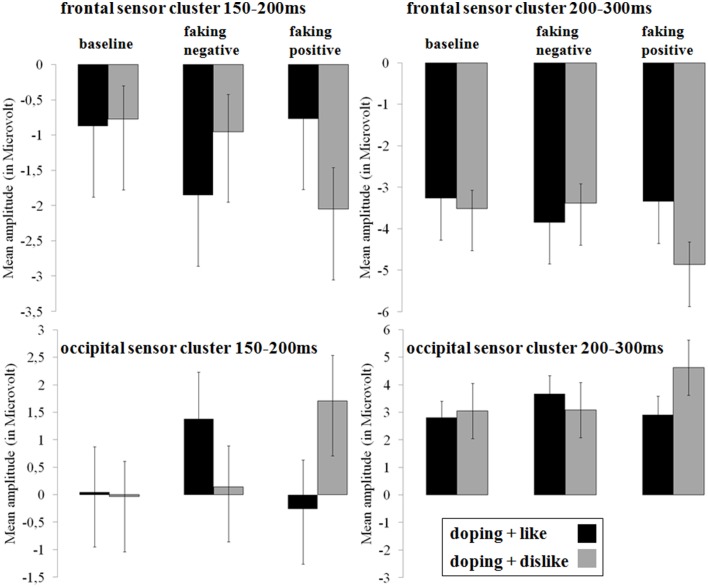
Mean amplitudes in microvolt for early effects over frontal and occipital sensor clusters. Error bars represent ±1 standard error of the mean (SEM).